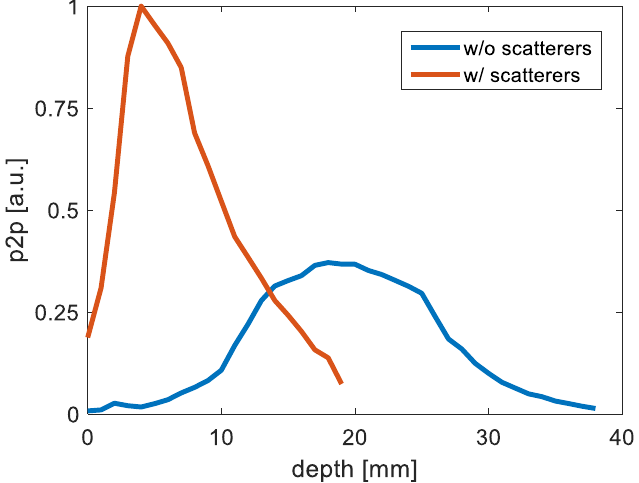
Figure 6. The peak-to-peak values of the optoacoustic reconstruction of a thin copper wire positioned in a scattering-free medium (red) and a tissue-mimicking scattering medium (blue).